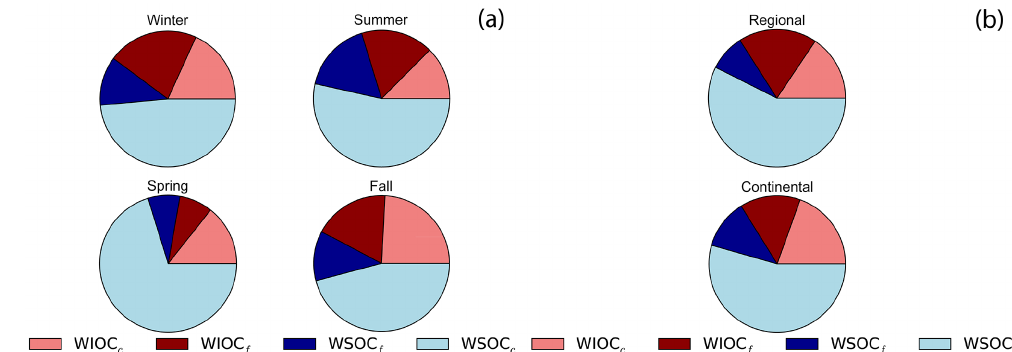
Figure 7. The contribution of water-soluble and water-insoluble organic carbon from fossil-dominated sources (WSOC f and WIOC f ) as well as water-soluble and water-insoluble organic carbon from contemporary sources (WSOC c and WIOC c ) to the total organic carbon. (a) Con- tribution of different carbon fractions during winter, summer, spring, and fall. (b) Contribution of different carbon fractions for modified marine and continental air mass